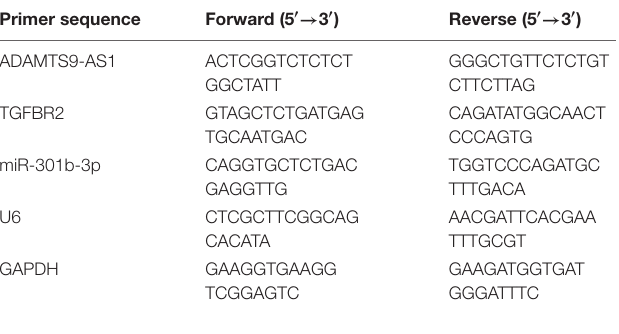
TABLE 1 | qRT-RCR primer sequences. Primer